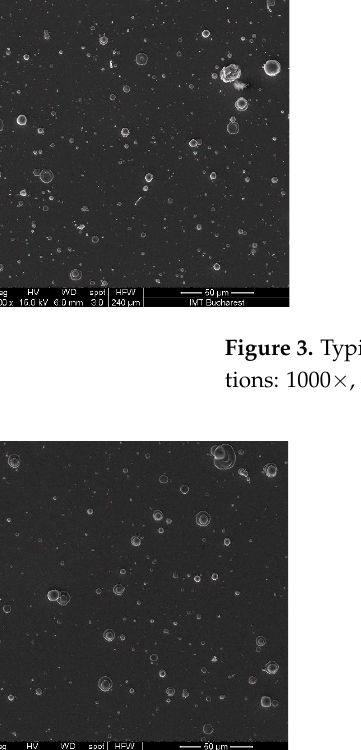
Figure 4. Typical SEM images of the surface morphology of a HEN6 thin film at different magnifi- cations: 1000×, 4000×, and 15,000×, from left to right, respectively.